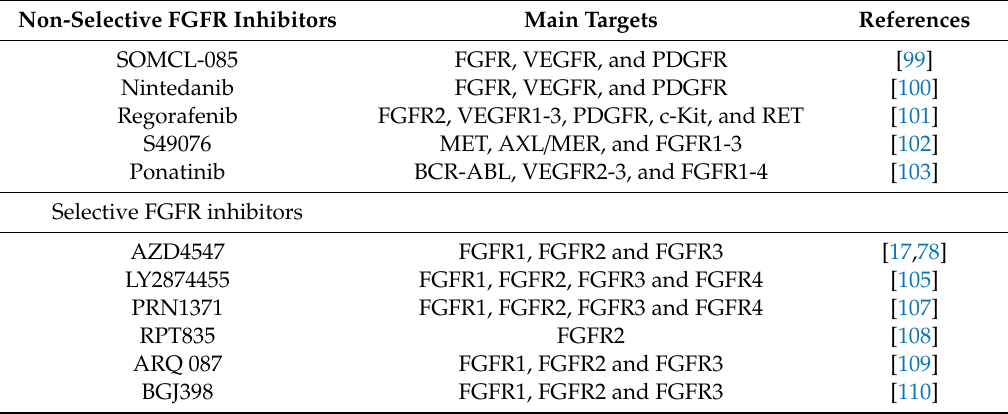
Table 2. The list of non-selective and selective FGFR tyrosine kinase inhibitors reported in GC. Non-Selective FGFR